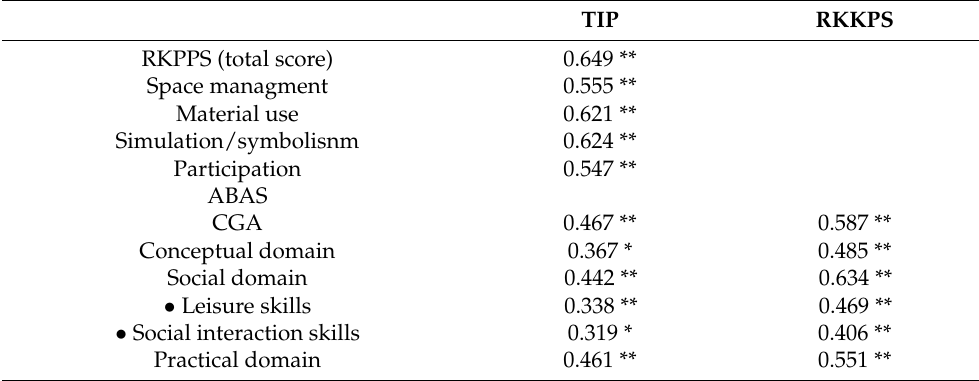
Table 3. Pearson correlations between the TIP and RKKPS and subsections of the ABAS Social Index.